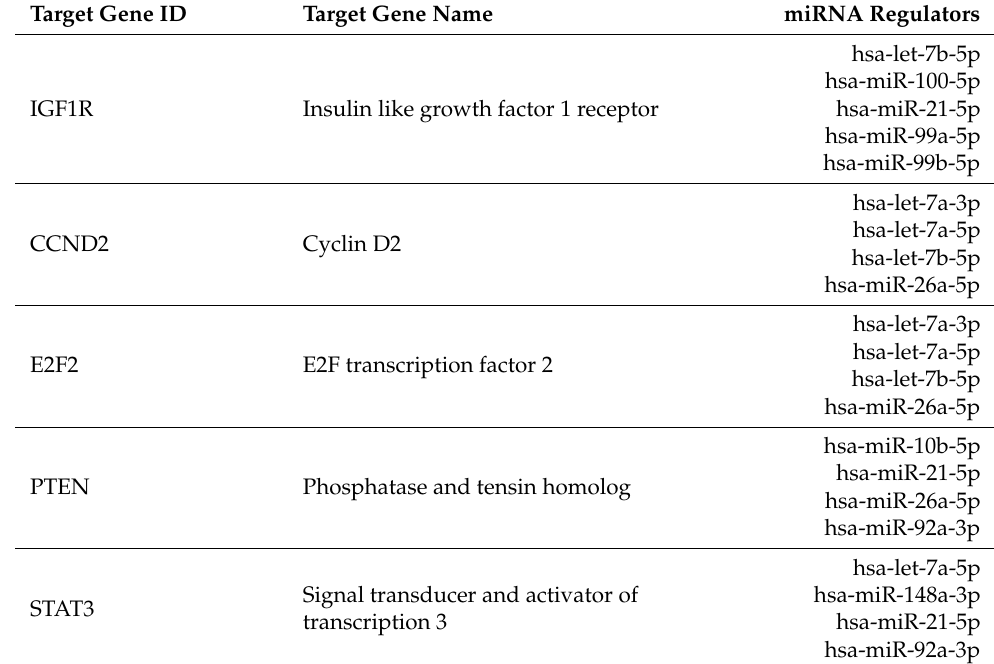
Table 3. Common targets of the 10 highest-ranked EV miRNAs.